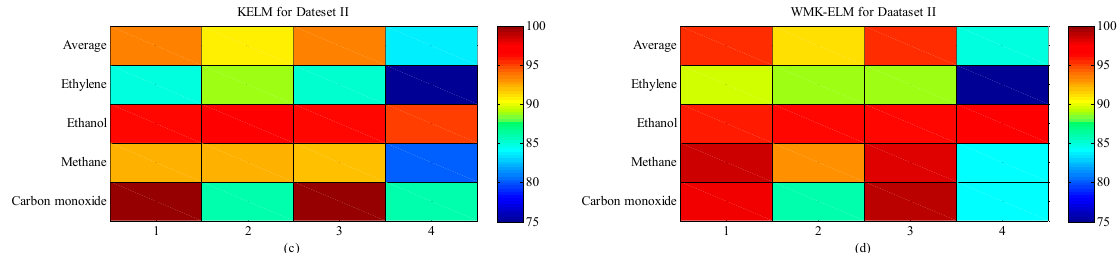
Figure 3. Classification results of QWMK-ELM and KELM for Dataset I and Dataset II. (Note: QWMK-ELM and KELM represent the quantum-behaved particle swarm optimization (QPSO)-based weighted multiple kernel extreme learning machine and kernel extreme learning machine respectively. In subplots ( a ) and ( c ), 1, 2, 3, and 4 represent Gaussian-kernel, polynomial-kernel, wavelet-kernel, and sigmoid-kernel, respectively. In subplots ( b ) and ( d ), 1, 2, 3, and 4 represent weighted-Gaussian-kernel, weighted-polynomial-kernel, weighted-wavelet-kernel, and weighted-sigmoid-kernel.)